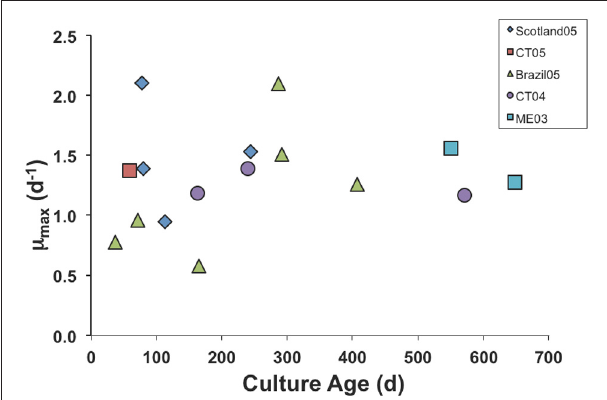
FIGURE 1 | Maximum growth rate parameter in numerical response curves for various isolates of S. rassoulzaegani fed Tetraselmis chui (PLY429), as a function of time since isolated. Strain designations indicate isolation locale (CT, Connecticut USA; ME, Maine USA) and year of isolation.